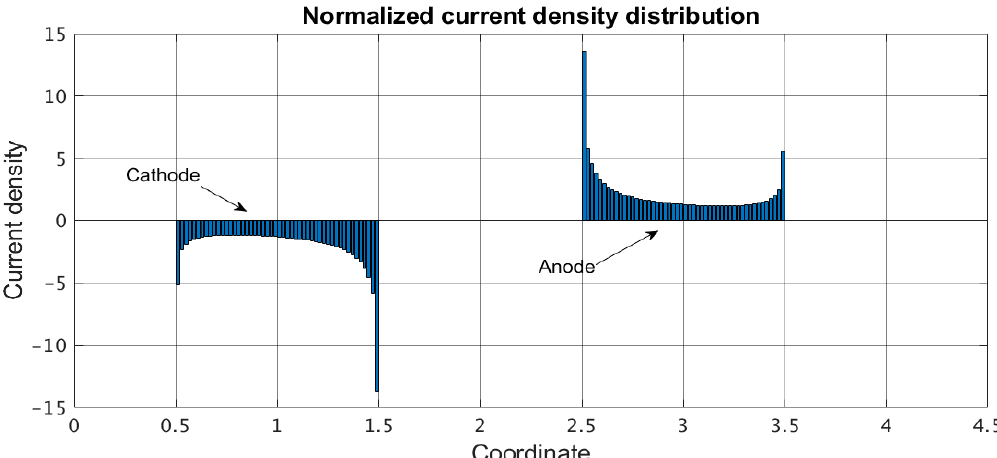
Figure 3. Dimensionless current density distribution. Transforming cell parameters: 𝑑(cid:4634) = 2,𝑎(cid:3556) = 1,𝑎(cid:3556) (cid:3030) = 1 . Only portions of electrodes corresponding to the positive coordinates are shown.